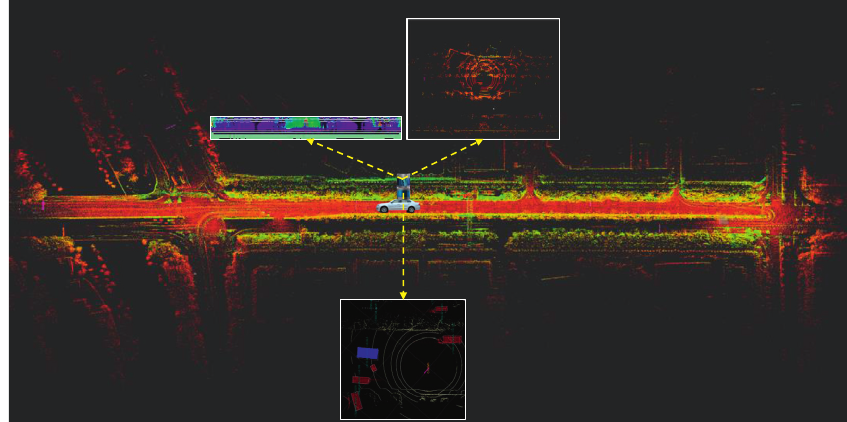
Figure 7: The test route and road information collection scene.